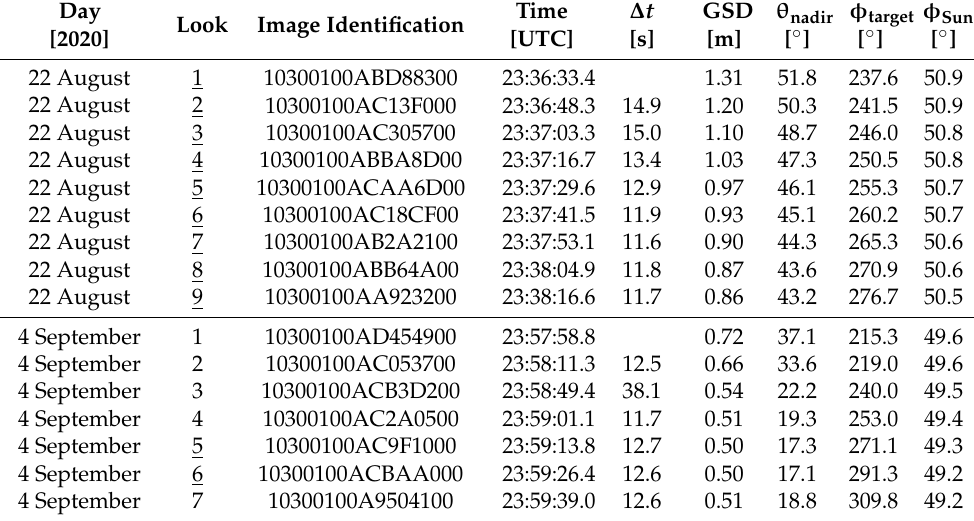
Table 1. Sampling details for WorldView-2 multi-look data collected on the two days examined in this study. Underlining indicates those looks analyzed in this study. The value ∆ t is the time difference between successive looks. GSD is Ground Sample Distance, or resolution size, of a single pixel on the ground; listed values are for the panchromatic wavelength band. The off-nadir angle is given by θ φ ) are measured from the satellite to either the ground target or the sun. Sun nadir . Azimuth angles ( elevation angles were ~42.6 ◦ for 22 August and ~50.4 ◦ for 4 September. Note that local Australian Eastern Standard Time (AEST) is UTC plus ten